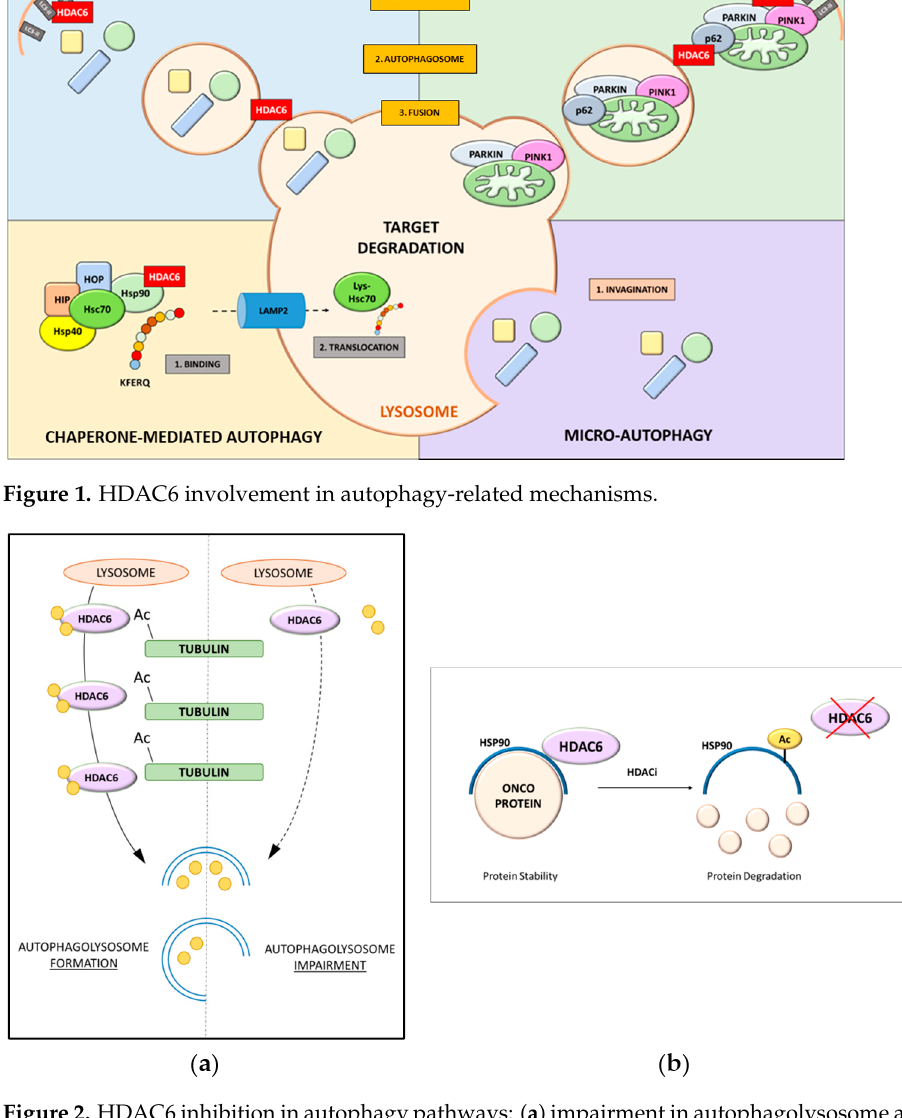
Figure 2. HDAC6 inhibition in autophagy pathways: ( a ) impairment in autophagolysosome